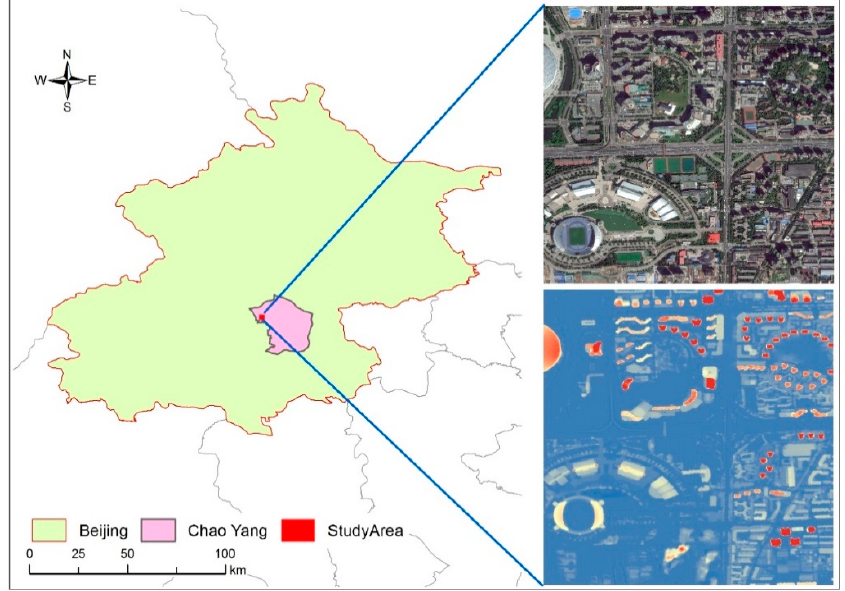
Figure 3. Original data of the study area.